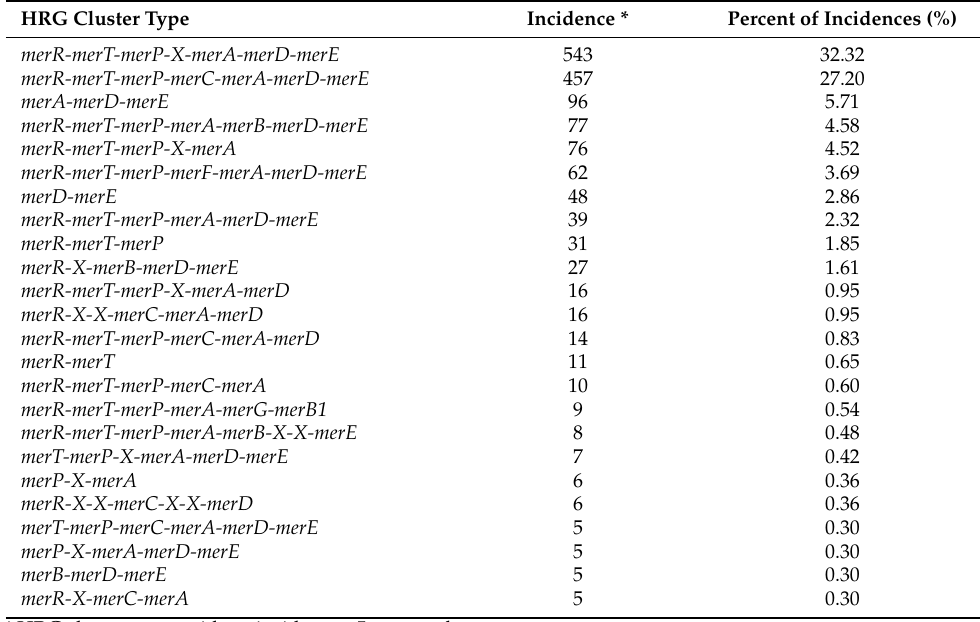
Table 2. Diversity of the HRG cluster types in plasmid